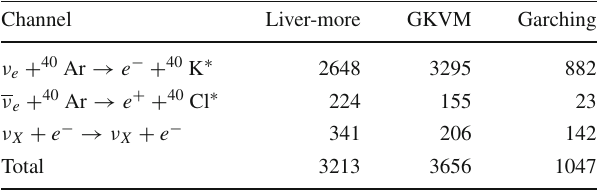
Table 1 Event counts computed with SNOwGLoBES for different supernovamodelsin40ktonofliquidargonforacorecollapseat10kpc, for ν e CC and ¯ ν e CC channels and ES ( X represents all flavors) on elec- trons. Event rates will simply scale by active detector mass and inverse square of supernova distance. No flavor transitions are assumed for the “Livermore”and“Garching”models;the“GKVM”modelincludescol- lectiveeffects.Notethatflavortransitions(bothstandardandcollective) will potentially have a large, model-dependent effect, as discussed in Sect.